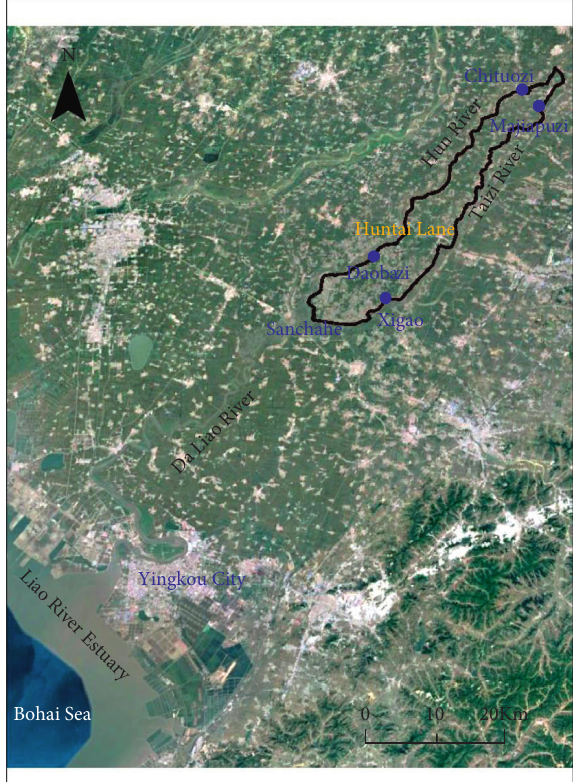
Figure 4: The location of the HTL.